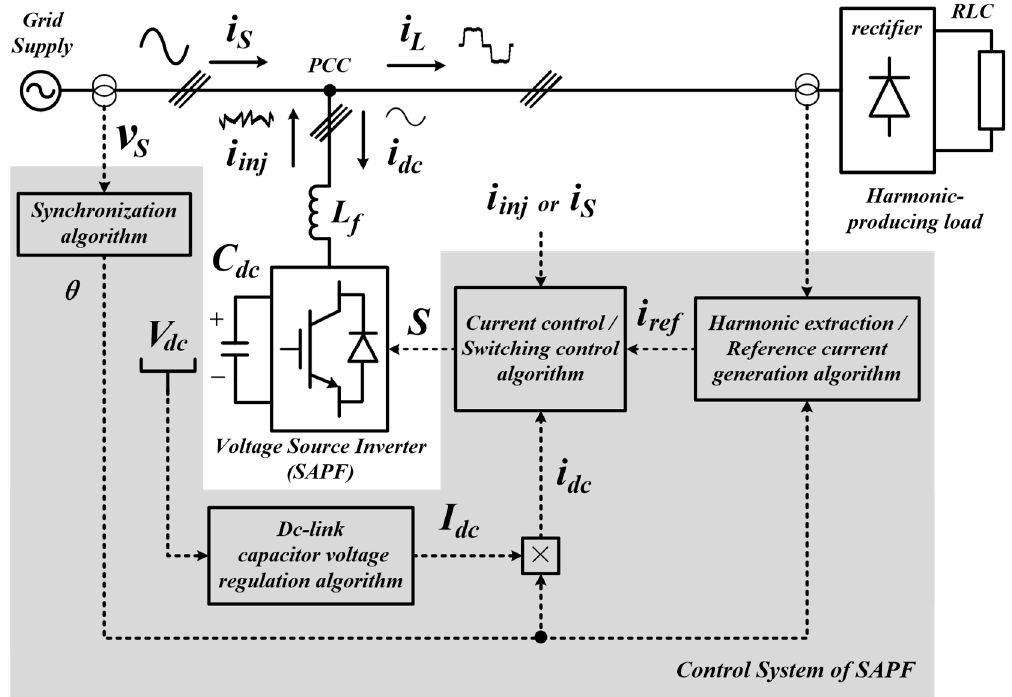
Figure 1. Typical power circuits connection of voltage source inverter (VSI)-based shunt active power filter (SAPF) and the associated control algorithms in its control system.